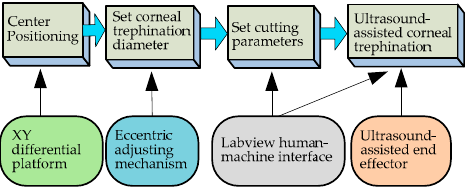
Figure 13. A preliminary exploration of human–machine cooperative experimental procedures.